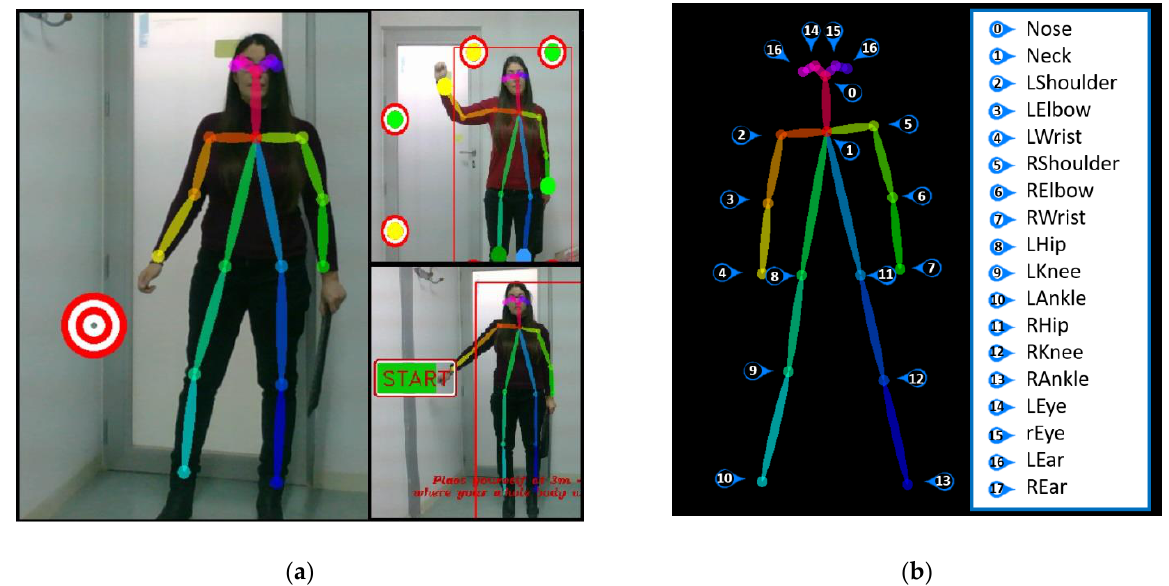
Figure 3. Visual aid, decoration and instructions. ( a ) Virtual objects in ExerCam 2D. ( b ) COCO body key points.